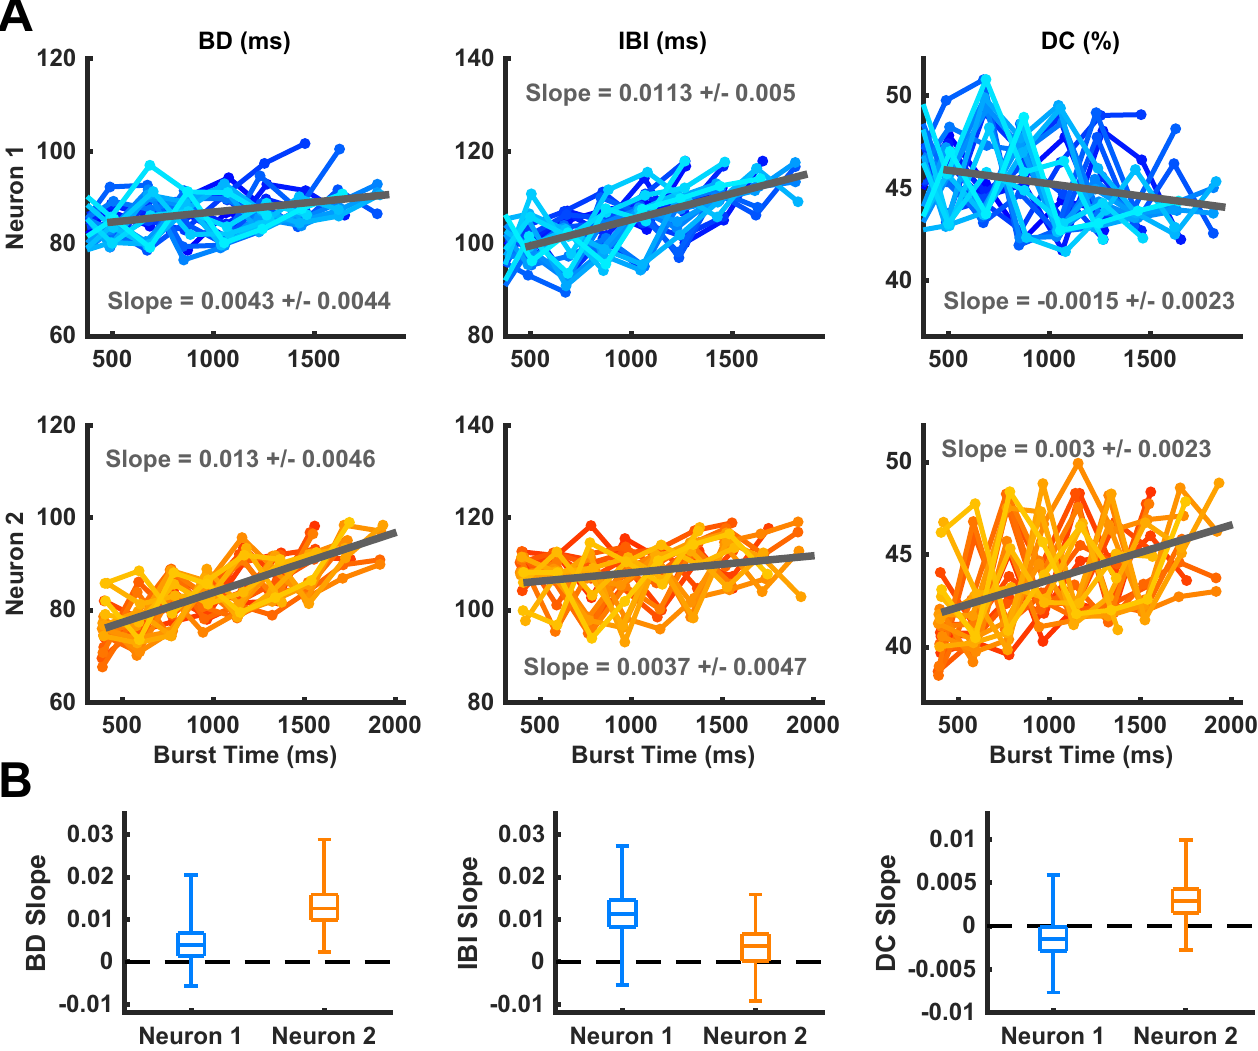
Fig 5. Simulated burst durations (BD), interburst intervals (IBI), and duty cycles (DC) and their linear regression lines as functions of the burst onset time during transient paw-shake-like responses. We generated 286 different cases of transient activity by applying a pulse of conductance with different pulse durations (between 700 ms and 1000 ms) and at different phases of locomotor-like activity of neuron #2 (between 20% and 40%). (A) Only 20 randomly chosen episodes of the paw-shake-like activity from these simulations are shown here to avoid congestion; the shown regression lines were computed using all 286 episodes. For each simulation, a linear regression line was computed for BD, IBI, and DC of neurons #1 and #2, and the average slope of these regression lines was calculated (shown in top and middle rows for neurons #1 and #2, respectively). (B) The median and quartile slopes are shown for BD slope, IBI slope, and DC